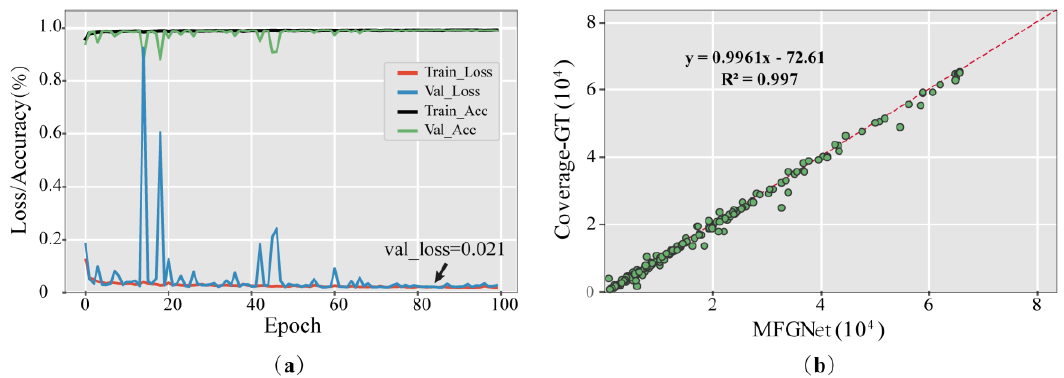
Figure 10. Diagram for evaluation model training on the validation set: ( a ) The loss and accuracy curve for the MFGNet; ( b ) The RCM plotted against the predicted cloud coverage for the MFGNet.